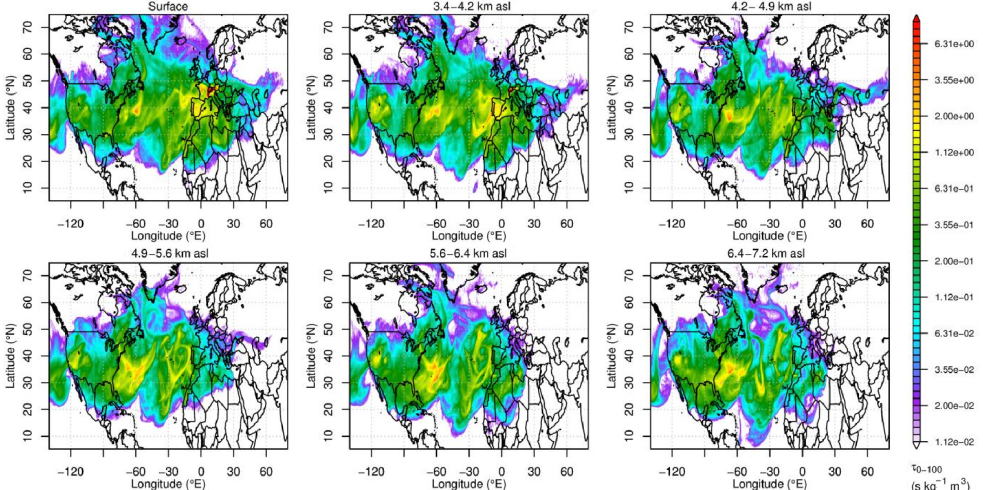
Figure 8. Surface source sensitivity (footprints) of the air masses at JFJ (surface in situ) and in the sub-columns above JFJ in March (CO 2 maximum of the NDIR data set) in the period 2009 to 2011 simulated with FLEXPART. The height of the sub-columns is given above the according subplots, the x axis is the longitude, the y axis represents the latitude, the color code of the sensitivity is given at the right side. correlation of 0.071 (0.084 high-resolution data vs.